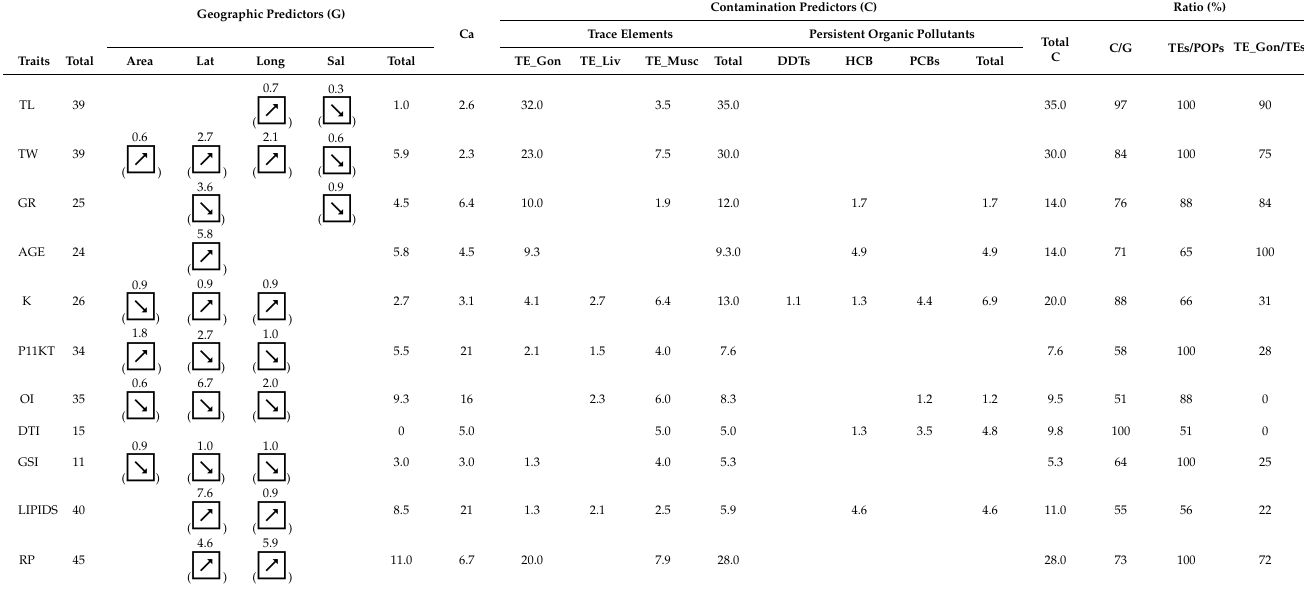
Model performance is expressed as pseudo-variance (R², %) scores that explain the variation in the fitness-related traits of female silver eels given for significant geographic (G; Lat: latitude; Long: longitude; Sal: salinity), local (catchment effect Ca) and contamination (C) predictors. Different ratios were calculated: C/G (relative importance of the contaminants compared to the geographic predictors), TEs/POPs (trace elements (TEs) compared to muscular persistent organic pollutants (POPs)) and TE_gon/TEs (gonadic TEs compared to all TEs). The total variance represents the variance for all significant predictors, G predictors, TEs and POPs predictors and all C predictors. Empty cells correspond to non-significant predictors and arrows in parentheses indicate the correlation trends between significant G predictors and traits. All models have 75 eels except P11KT ( n = 62).